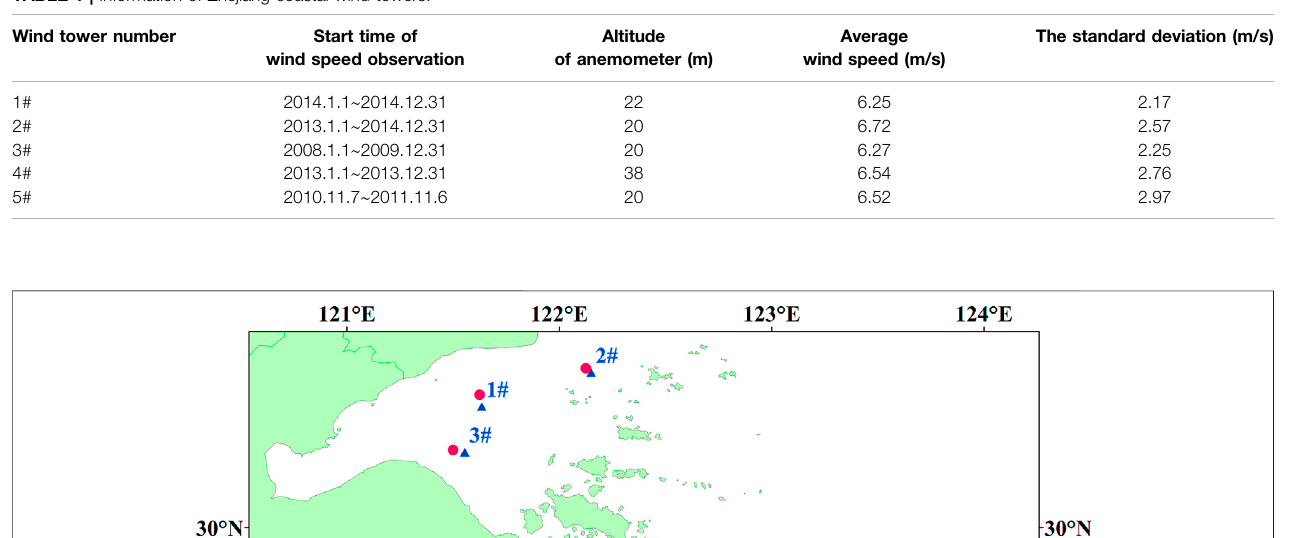
TABLE 1 | Information of Zhejiang coastal wind towers.